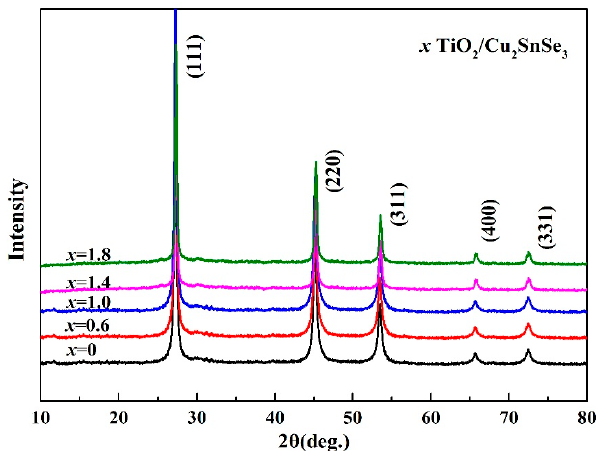
Figure 4. The XRD patterns of the x vol % TiO 2 /Cu 2 SnSe 3 composites.